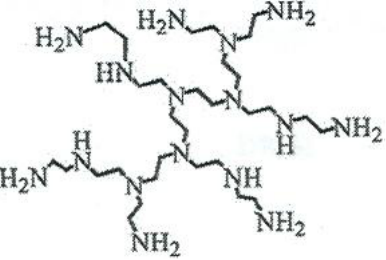
Figure 1. Schematic illustration of the hyperbranched polyethyleneimine, HBPEI.